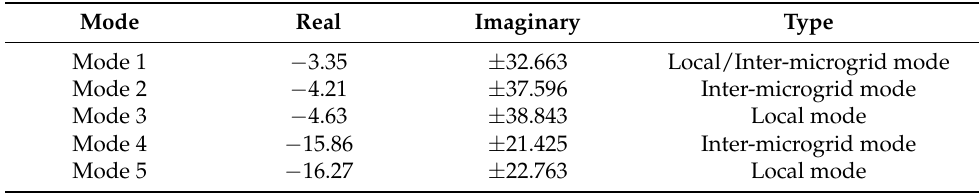
Table 2. Summary of critical oscillatory modes of the